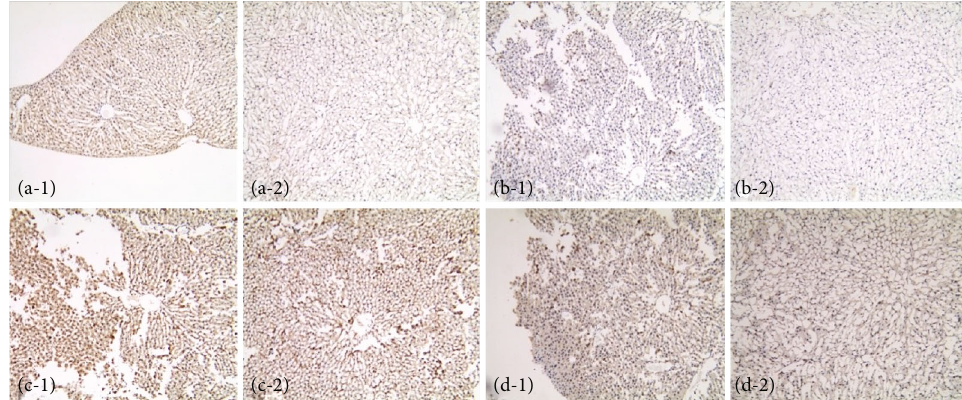
Figure 16: Immunohistochemical detection of SIRT1, HIF-1a, Egr-1, and TGF- β 1 in the liver ( × 100). (a – d) SIRT1, HIF-1a, Egr-1, and TGF- β 1, respectively. 1 and 2 indicate the DN+LRG and control groups, respectively. Control: diabetic nephropathy group; DN+LRG: diabetic nephropathy+liraglutide group.